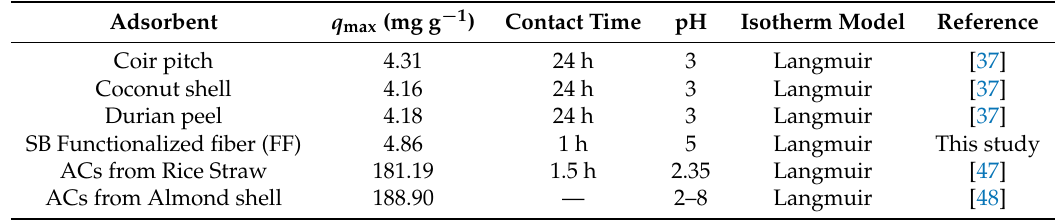
Table 2. Comparison of FF adsorption performances with other